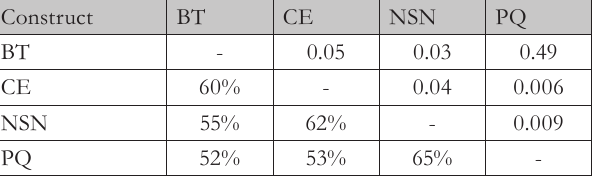
Tab. 2 - Discriminant validity test using AVE and correlation methods. Source: